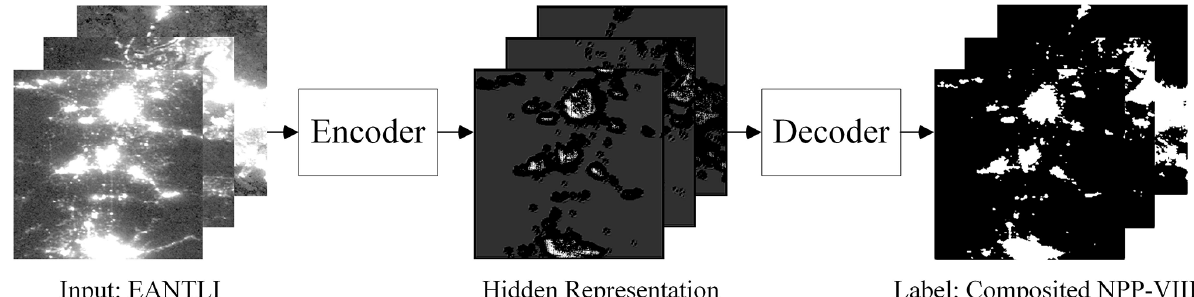
Figure 3. The framework of the auto-encoder